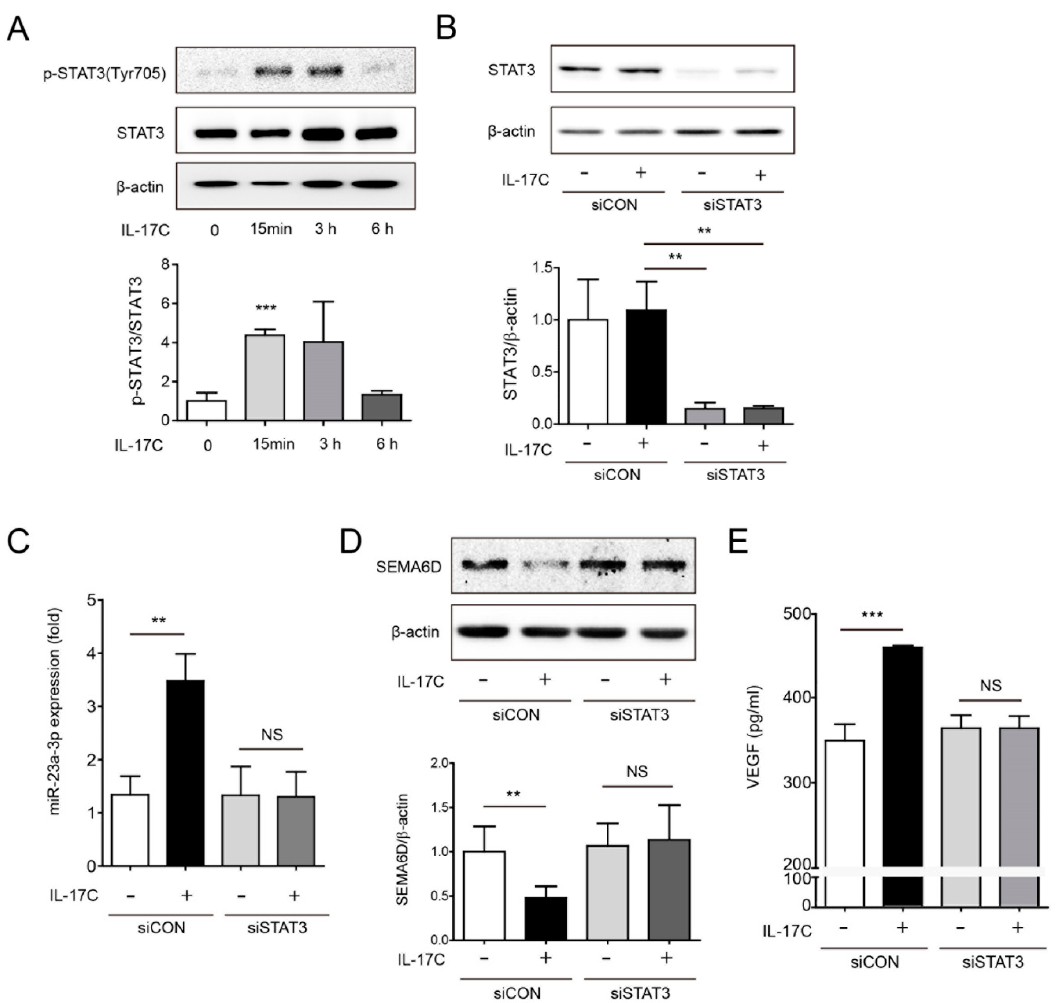
Figure 6. IL-17C activates STAT3 signaling. ( A ) Representative bands of Western blotting and quantitative analyses of STAT3 phosphorylation by IL-17C stimulation in DLD-1 cells are shown. STAT3 and β -actin were used as a loading control. Error bars, SD ( n = 3). *** p < 0.001 vs. the 0 h group. ( B ) STAT3 protein expression was shown in cells transiently transfected with siRNA of STAT3. The bar graph below shows the result of quantitative analyses. Error bars, SD ( n = 3). ** p < 0.01. ( C ) miR-23a-3p expression in transiently transfected DLD-1 cells with siSTAT3 was measured using qPCR. Error bars, SD ( n = 3). ** p ≤ 0.01; NS, not significant. ( D ) SEMA6D protein expression in siSTAT3-transfected and IL-17C-stimulated DLD-1 cells was detected using Western blotting. The results of quantitative analyses are shown below. β -actin was used as a loading control. Error bars, SD ( n = 3). ** p < 0.01. ( E ) ELISA was conducted to determine VEGF levels in siSTAT3-transfected DLD-1 cells. Error bars, SD ( n = 4). *** p < 0.001; NS, not significant.